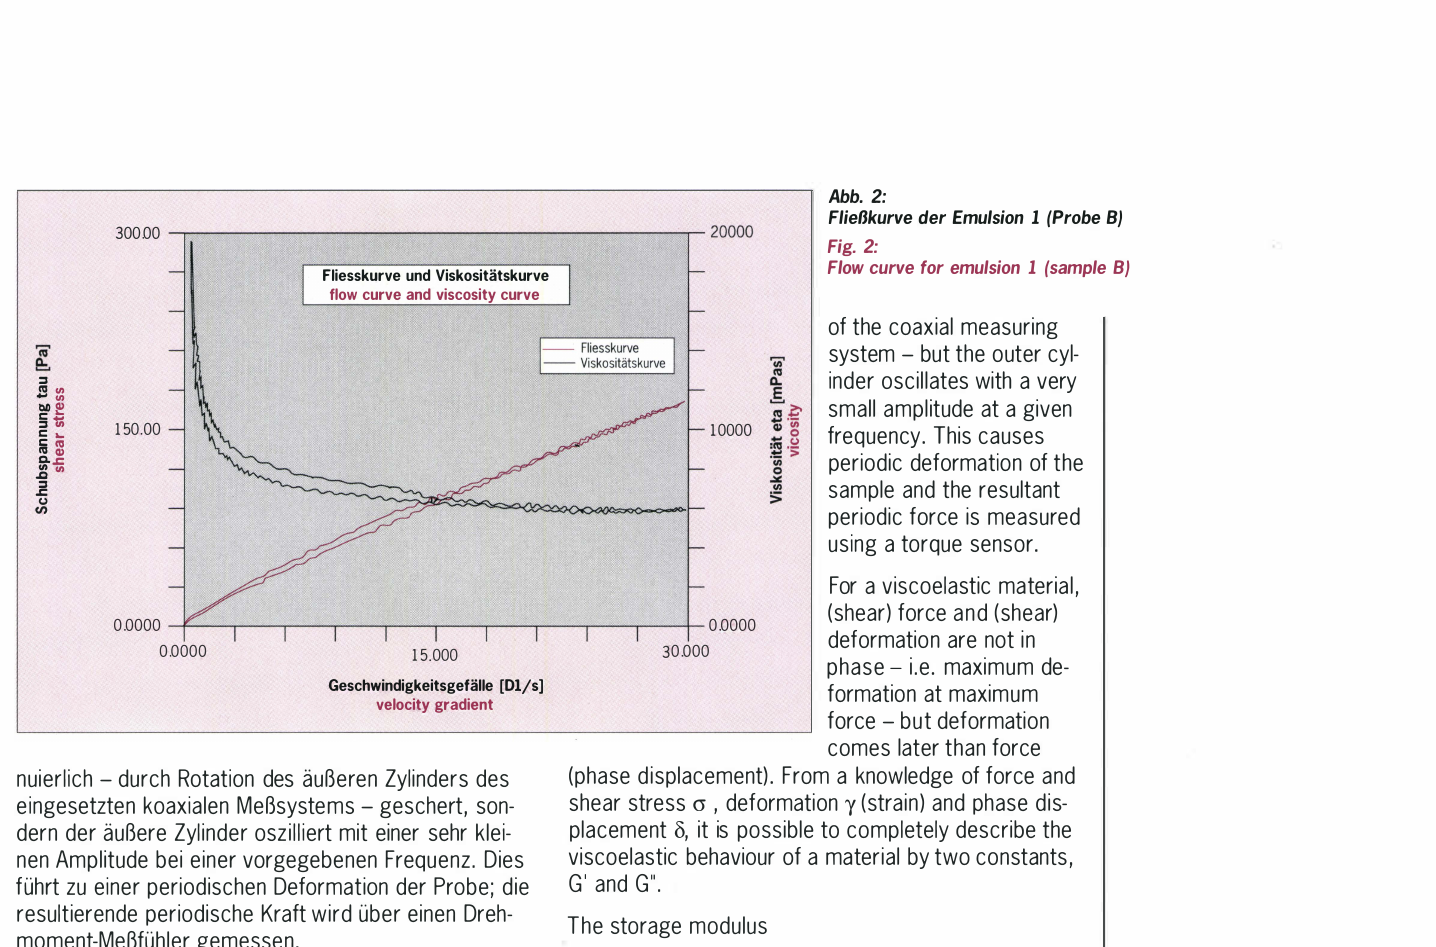
whereas the loss modulus G"= ( <JiYo) sin 8